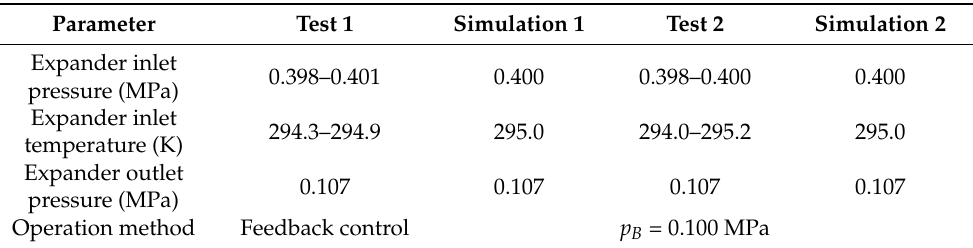
Table 2. The operating parameters of test and